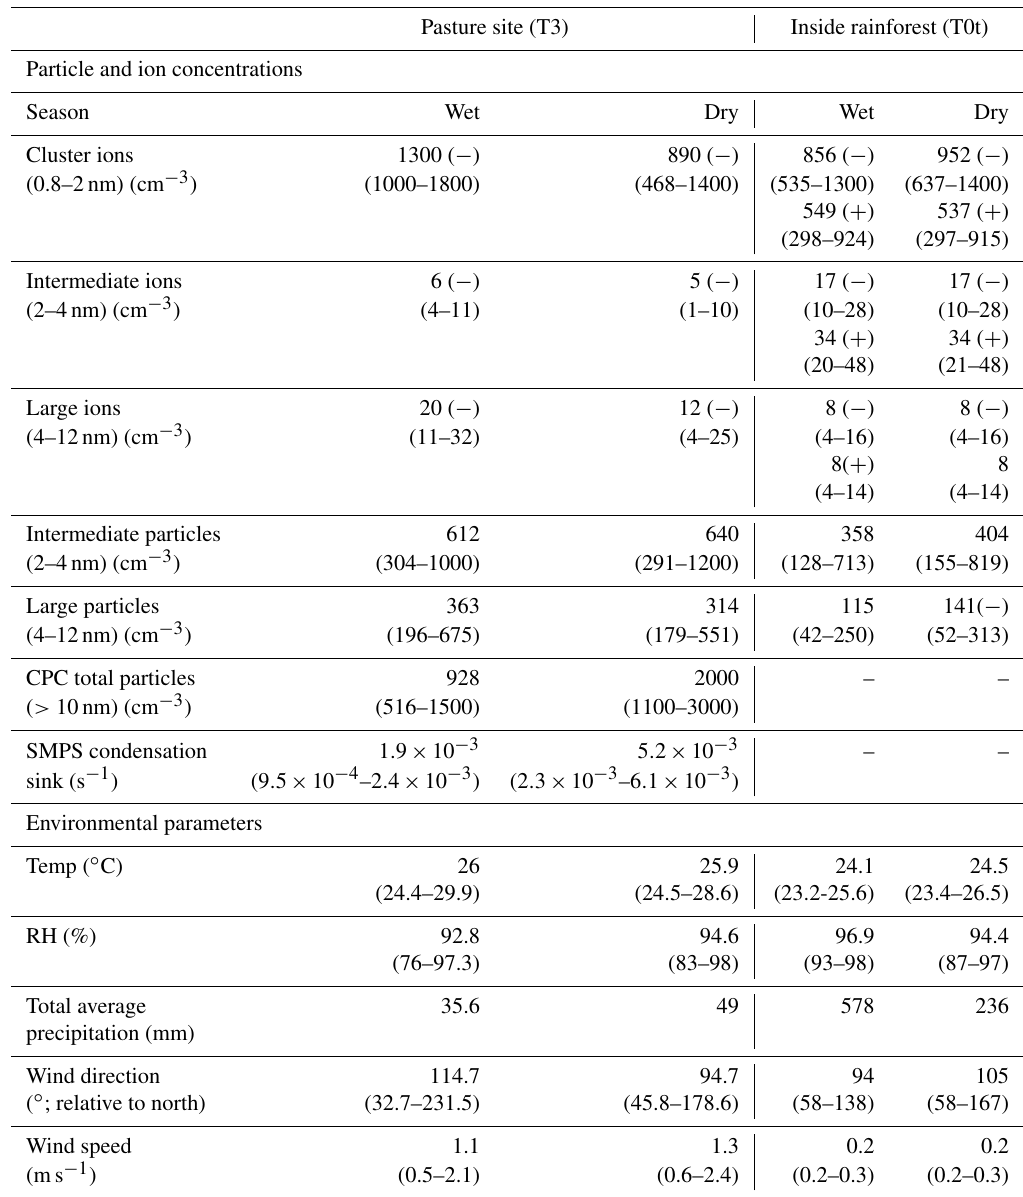
Table 2. A comparison of the two measurement sites and the wet and the dry season. The values from the pasture site are on the left-hand side, and the values from inside the rainforest site are on the right-hand side. The months for the wet season are January to June and July to December for both measurement sites. The aerosol and ion parameters from the NAIS measurements listed are the ion concentrations in three size bins (0.8–2, 2–4, and 4–12nm), the neutral particle concentrations in two different size bins from the NAIS (2–4 and 4–12nm), and the total particle concentrations ( > 10nm) from the MAO CPC measurements; the calculated condensation sink values from the SMPS are also shown. The numbers present median values and the 25th–75th percentiles are in brackets. The environmental parameters shown are temperature, relative humidity, precipitation rate, wind direction, and wind